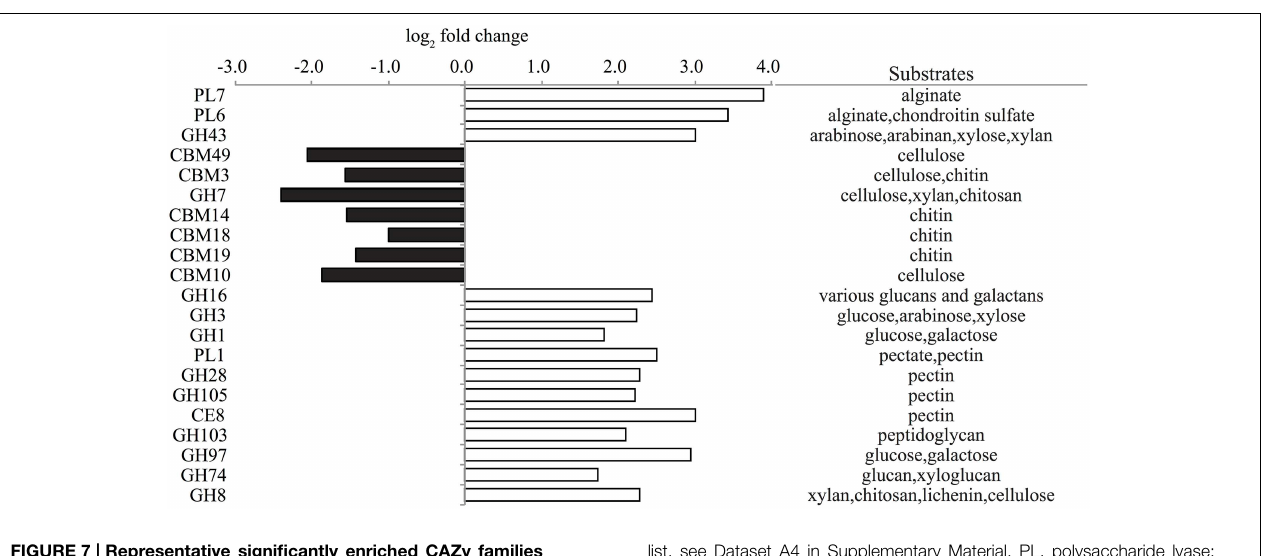
FIGURE 7 | Representative significantly enriched CAZy families (FDR < 1%) in live (positive, white) and poisoned (negative, black) sediment traps along with their potential substrates. For full family